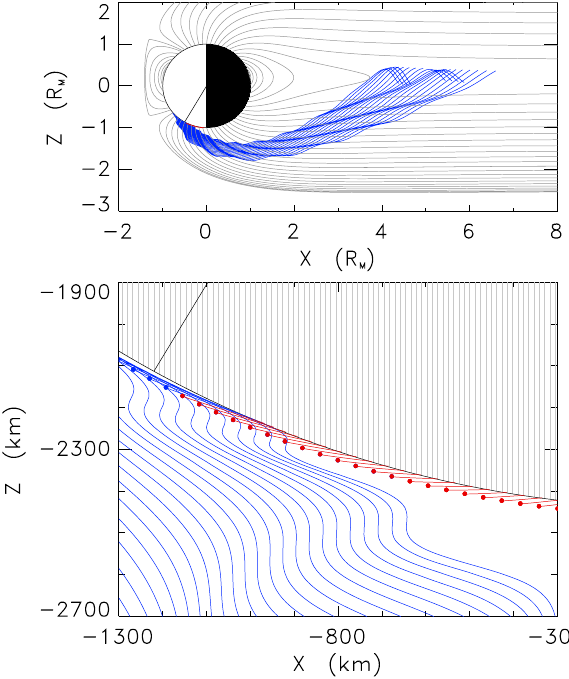
Fig. 7. Model trajectories of Na + ions ejected from the southern dayside sector. The bottom panel shows an enlarged view of the Na + paths at low altitudes. Ions that do not gain access to the mag- netotail are coded in red. The solid line in both panels depicts the − 60 ◦